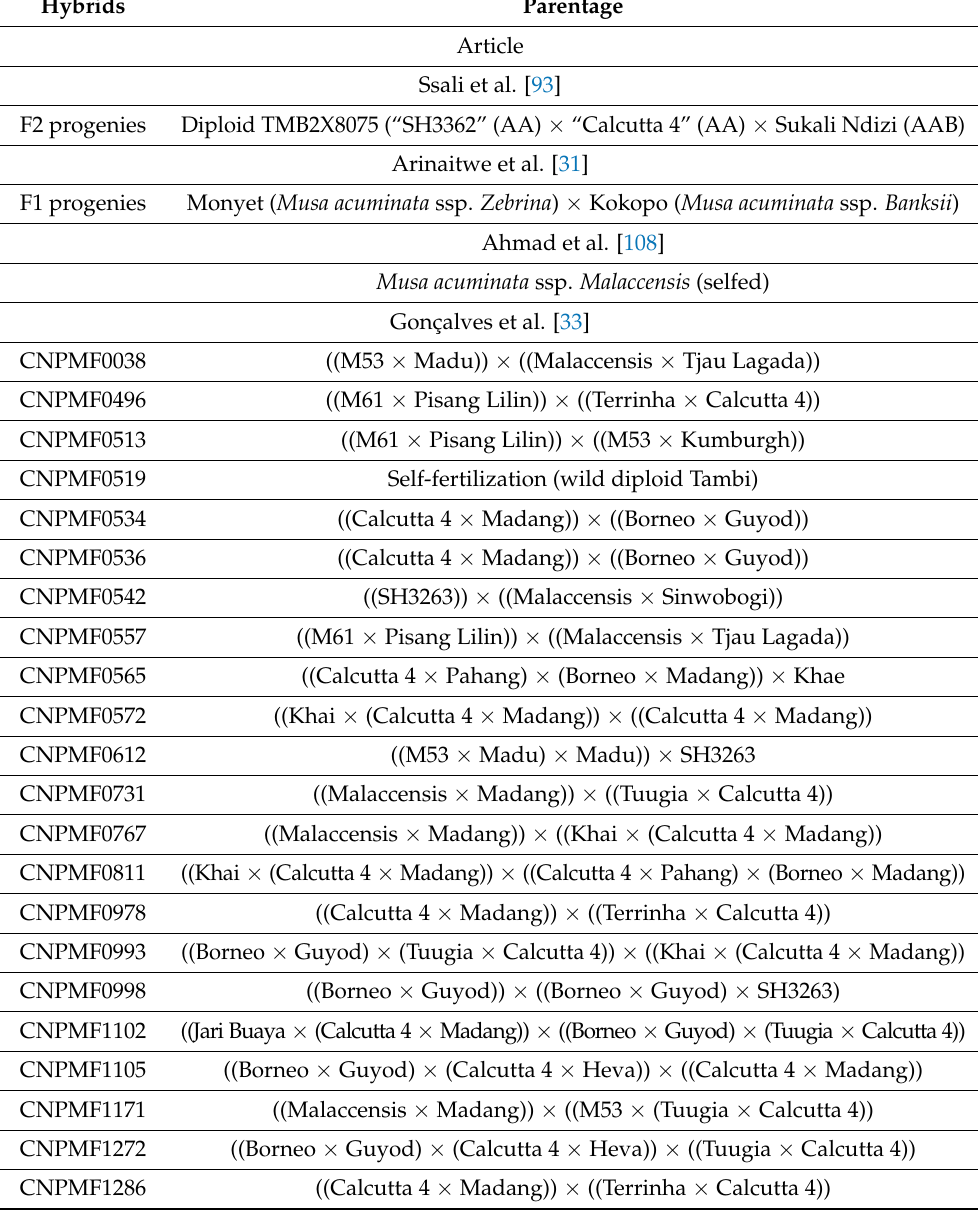
Table 6. Evaluation of hybrids and genetic inheritance studies in articles about the improvement of banana plants to fusarium wilt carried out in the last ten